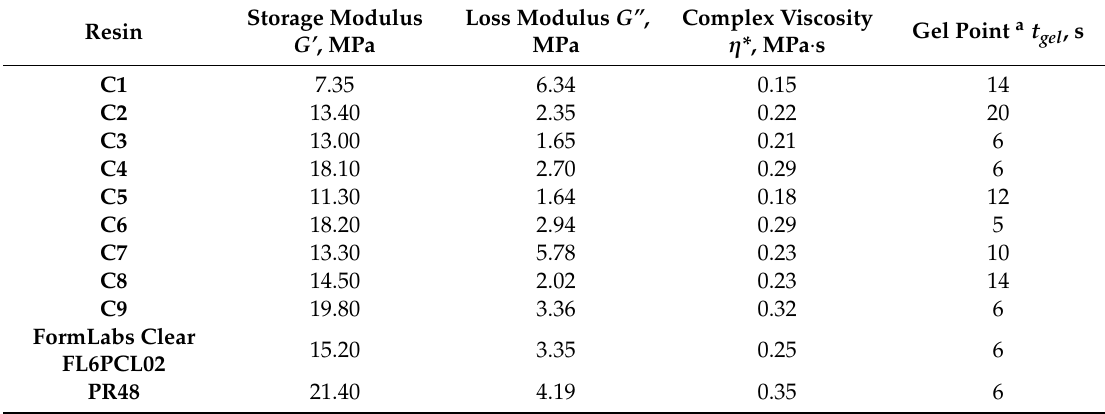
Table 2. Rheological characteristics of the resins C1 –